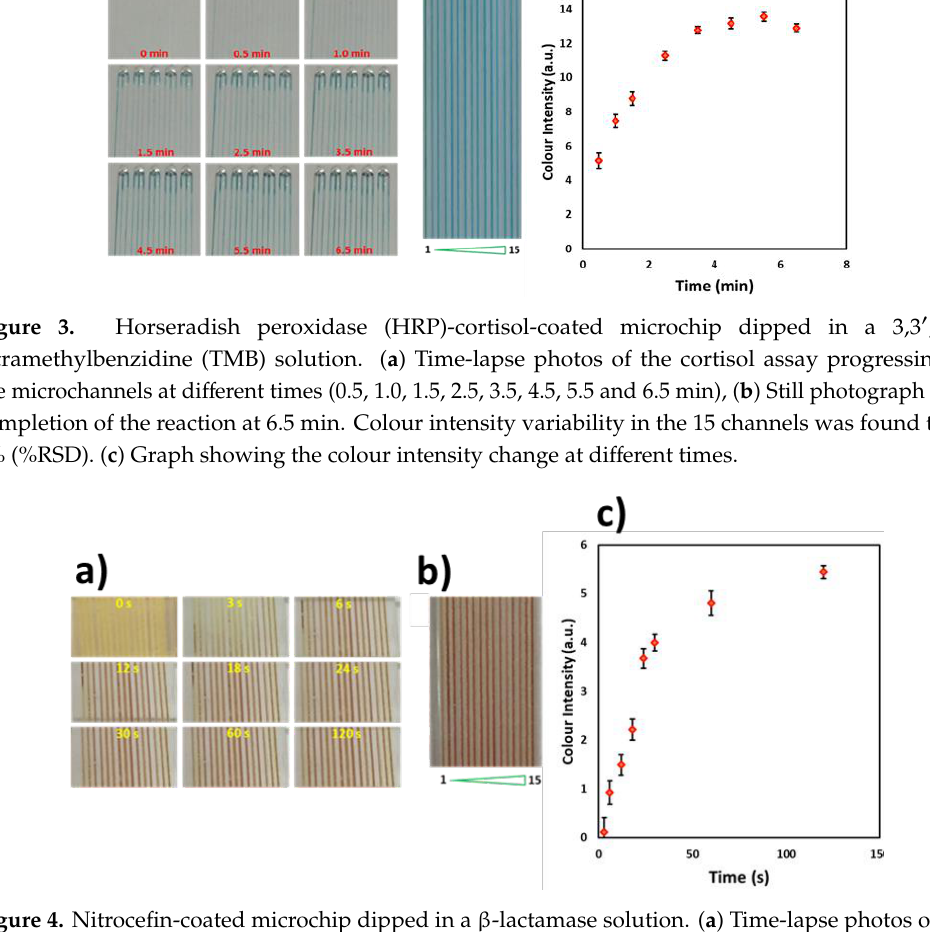
Figure 3. Horseradish peroxidase ( HRP)-cortisol- coated microchip dipped in a 3,3′,5,5′ - tetramethylbenzidine (TMB) solution. ( a ) Time-lapse photos of the cortisol assay progressing in the microchannels at different times (0.5, 1.0, 1.5, 2.5, 3.5, 4.5, 5.5 and 6.5 min), ( b ) Still photograph after completion of the reaction at 6.5 min. Colour intensity variability in the 15 channels was found to be 2% (%RSD). ( c ) Graph showing the colour intensity change at different times.